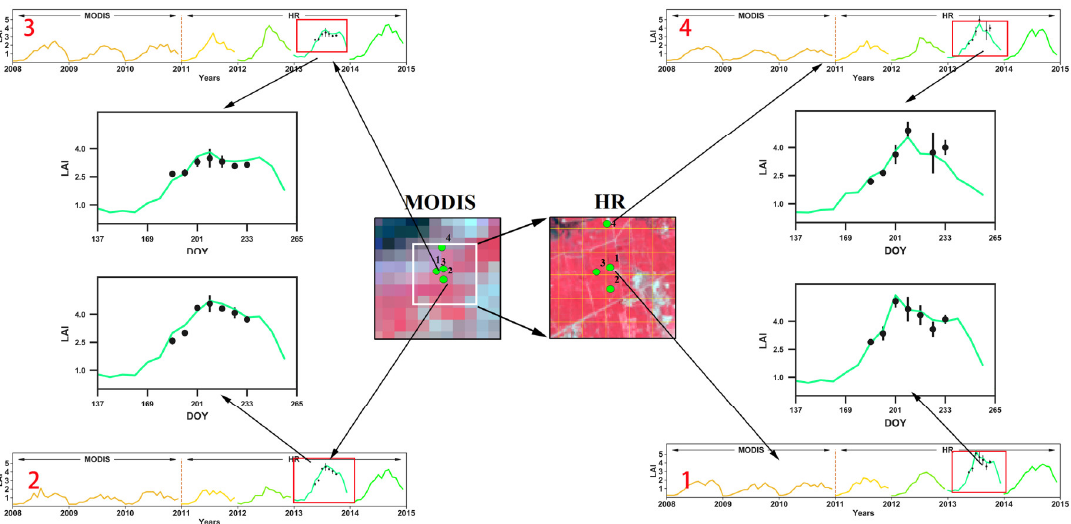
Figure 6. LAI dynamics derived from HR data using NARX prediction over the study sites and comparison with ground-measured LAI values by LAINet. 1–4 are the four ground sites in 2013. Mean values derive from multiple measurements by the LAINet instrument. Error bars indicate standard deviations of the LAINet measurements.